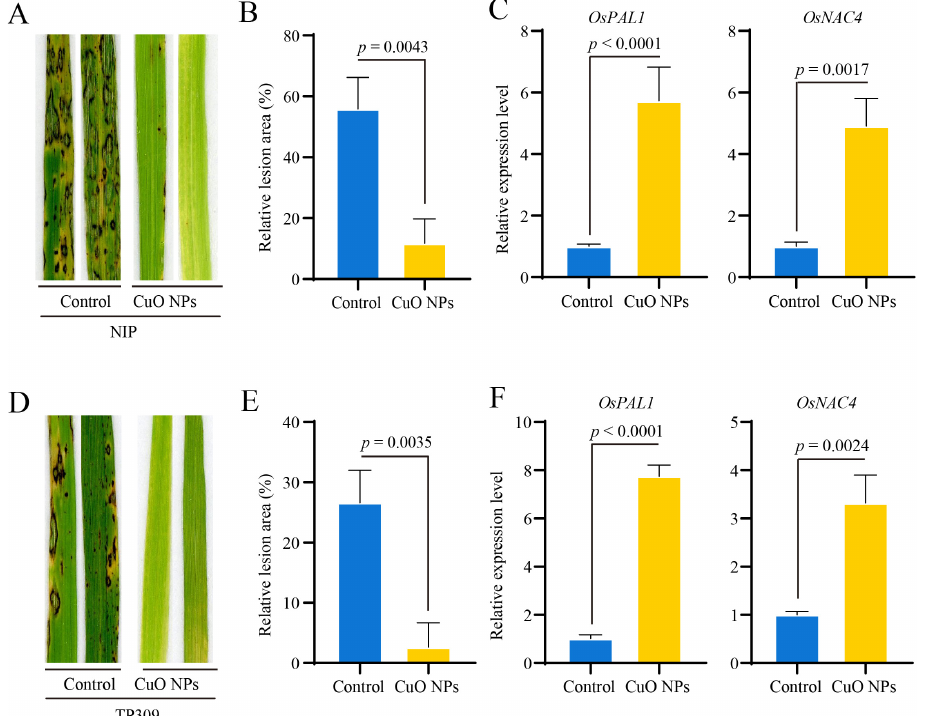
Figure 4. CuO NPs enhance the basal resistance against M. oryzae in rice. Disease symptoms ( A ), the relative lesion area ( B ), and relative expression levels of PR genes ( C ) of Oryza sativa subsp. Japonica cultivars Nipponbare rice seedlings inoculated with M. oryzae after treated with CuO NPs for 14 days. Disease symptoms ( D ), the relative lesion area ( E ), and relative expression levels of PR genes ( F ) of Oryza sativa subsp. Japonica cultivars TP309 rice seedlings inoculated with M. oryzae after treated with CuO NPs for 14 days. The relative lesion area was calculated by ImageJ. The relative transcript abundances were calculated using the 2 −ΔΔ C T method based on the abundance levels in the control samples. The Ubiquitin gene ( LOC_Os03g13170) was used as the internal control for normalization. The bars are shown as means ± SD of three replications. The student’s t -test was used to analyze the data and generate p